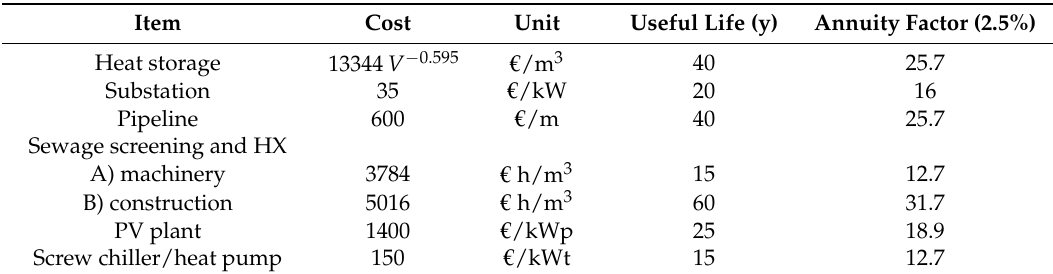
Table A5. Specific investment costs.